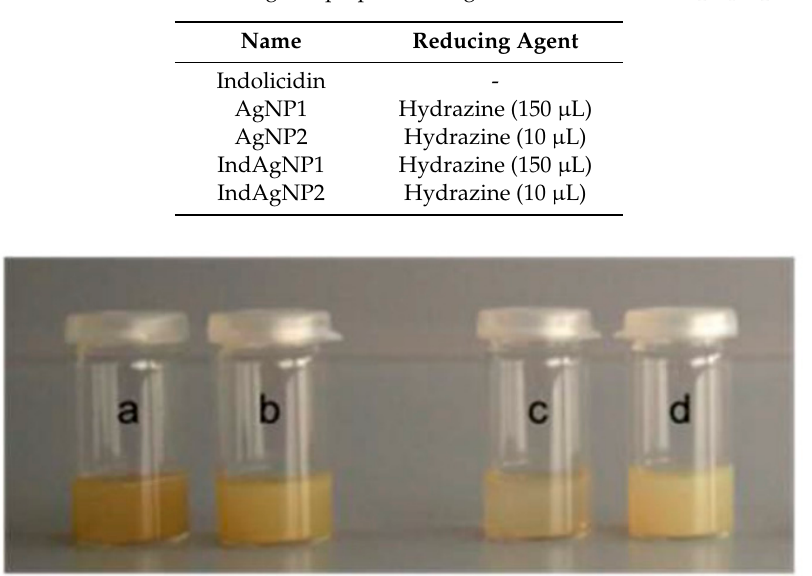
Table 1. Indolicidin and AgNPs prepared using different amount of N 2 H 4 ∙ H 2 O.